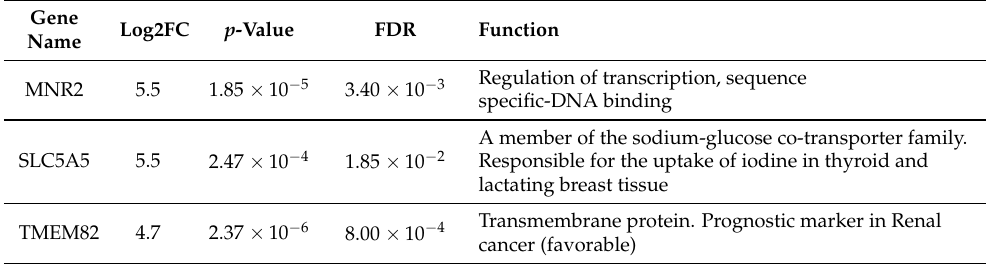
Table 2. Top 10 mRNAs that are upregulated in COVCAR cells in response to 2 mM metformin treatment compared to control as detected by RNA-seq analysis. Functions listed below are that of the protein encoded by the respective gene. FDR—false discovery